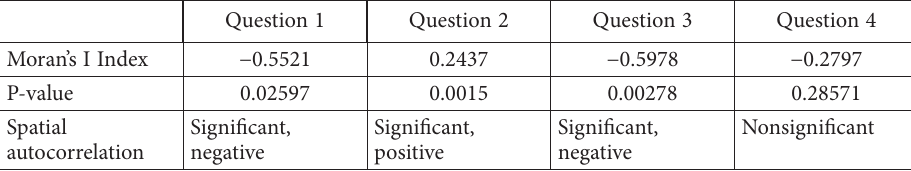
Table 7. Results of spatial autocorrelation testing (source: own processing)